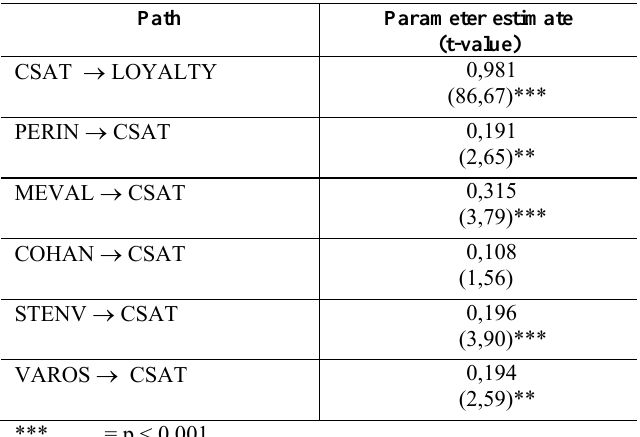
Table 1: Parameter estimates for model in Figure 2: The attitudinal